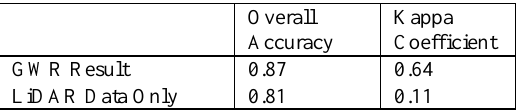
Table 3. Accuracy Evaluation